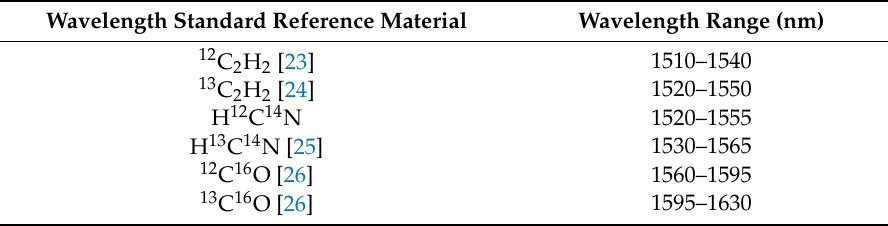
Table 2. Molecular gas cells as reference materials in the C and L bands for optical telecommunications.